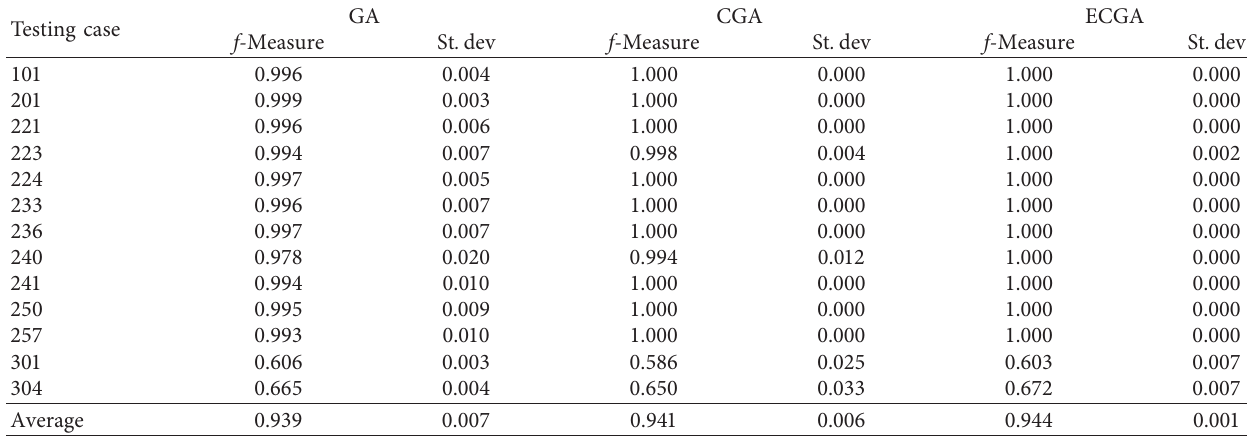
Table 5: Comparison of F -measure and its standard